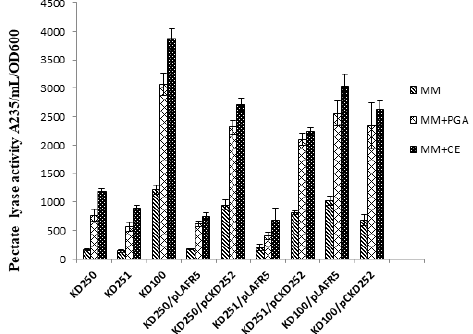
Figure 2. Quantitative assays for enzymatic activities of extracellular pectate lyase from wcaG + and wcaG − P. carotovorum strains. Cultures were grown in liquid MM, MM + CE and MM + PGA at 28 °C for 16 h. Pel activities were determined from cultural supernatant. The cosmid, pCKD252 (carrying wild type wcaG clone in pLAFR5) was used to complement the mutants KD250, KD251. Values are the mean (from four replicates) ± standard deviation.